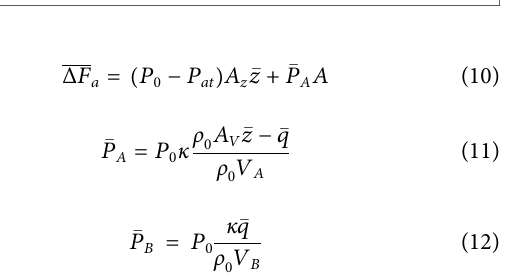
FIGURE 7 | Vibration test measurement scheme of the SPCC fl oating foundation vibration reduction system. (Redline is the outline of the SPCC fl oating foundation).